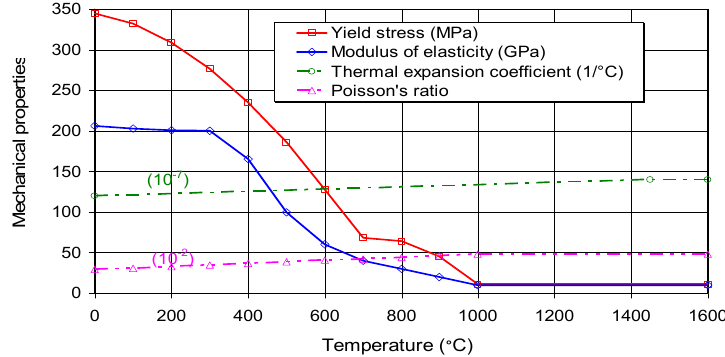
Figure 4. S355J2+N steel, thermal properties [32].